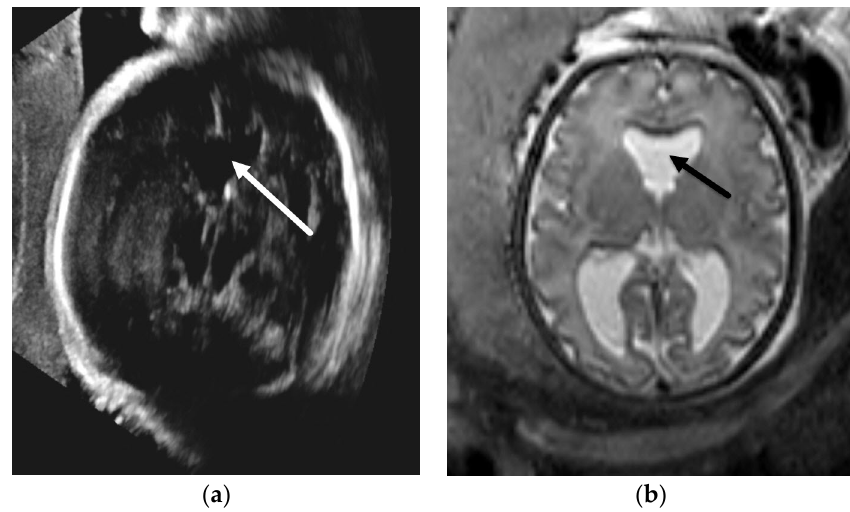
Figure 7. Isolated septal deficiency. Axial ultrasound image of the fetal brain in a 33-week GA fetus ( a ) demonstrating absence of the CSP (arrow). Axial T2-SSFSE image of the brain in the same patient ( b ) confirms absence of the CSP (arrow) with associated mild ventriculomegaly of the lateral ventricles. This patient had postnatal follow-up with normal ophthalmology exam and normal endocrine work up. Postnatal brain MRI did not demonstrate any additional anomalies.